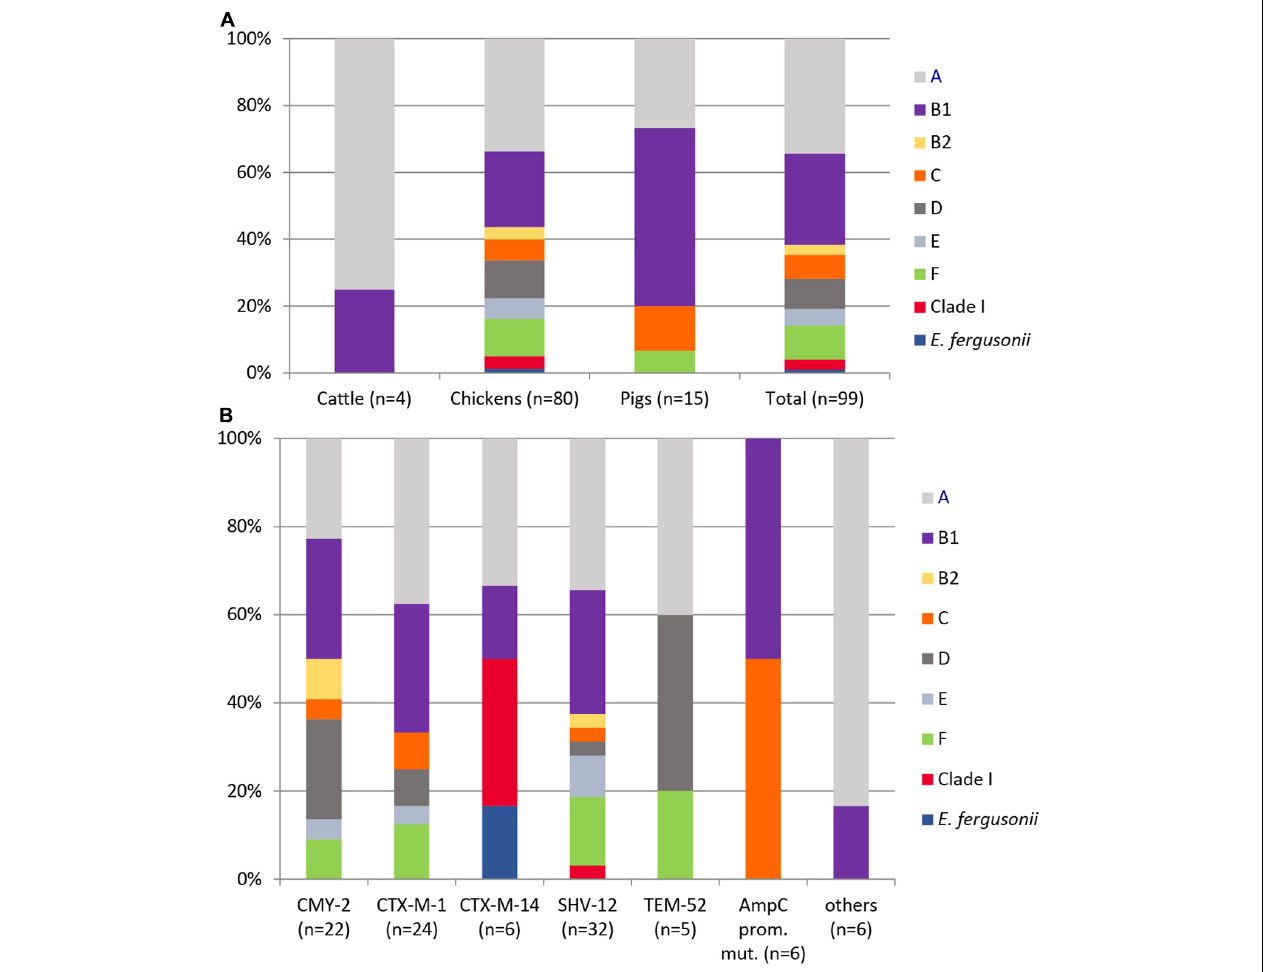
FIGURE 2 | Distribution of phylogenetic groups among 99 ESC-non-S/ESC-R Escherichia spp. isolates with respect to animal host (A) and ESBL/pAmpC genes and AmpC-promoter mutations (B) .